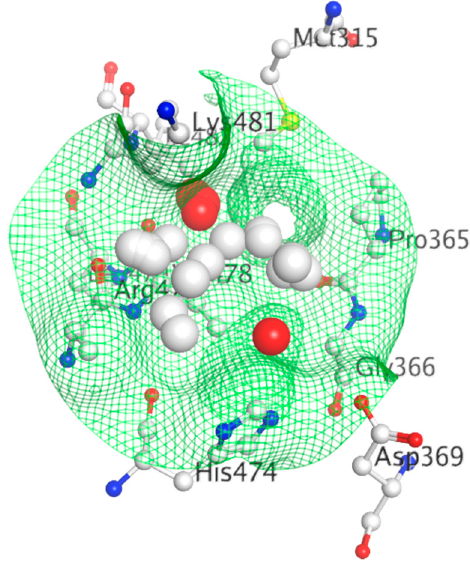
Figure 19. Location of potential BF3 site on ER-LBD fold (pdb: 3UUD).